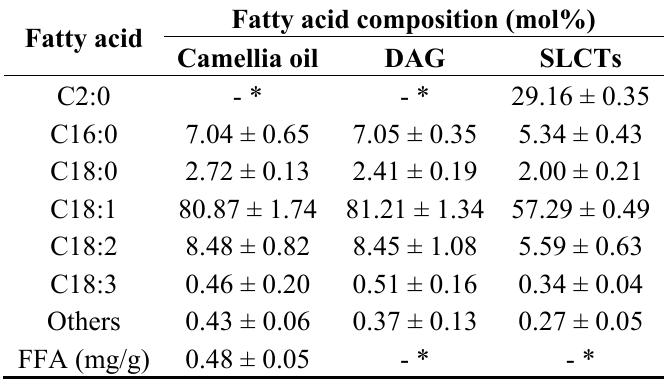
Table 2. FA composition of camellia oil, DAG and